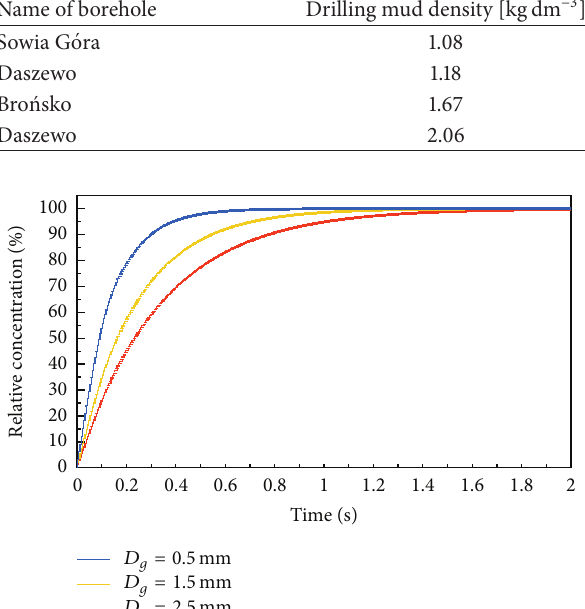
Figure 5: Changes of relative methane concentration 𝑐 𝑔 in bubbles of diameter 𝐷 𝑔 equal to 0.5, 1.5, and 2.5 mm.